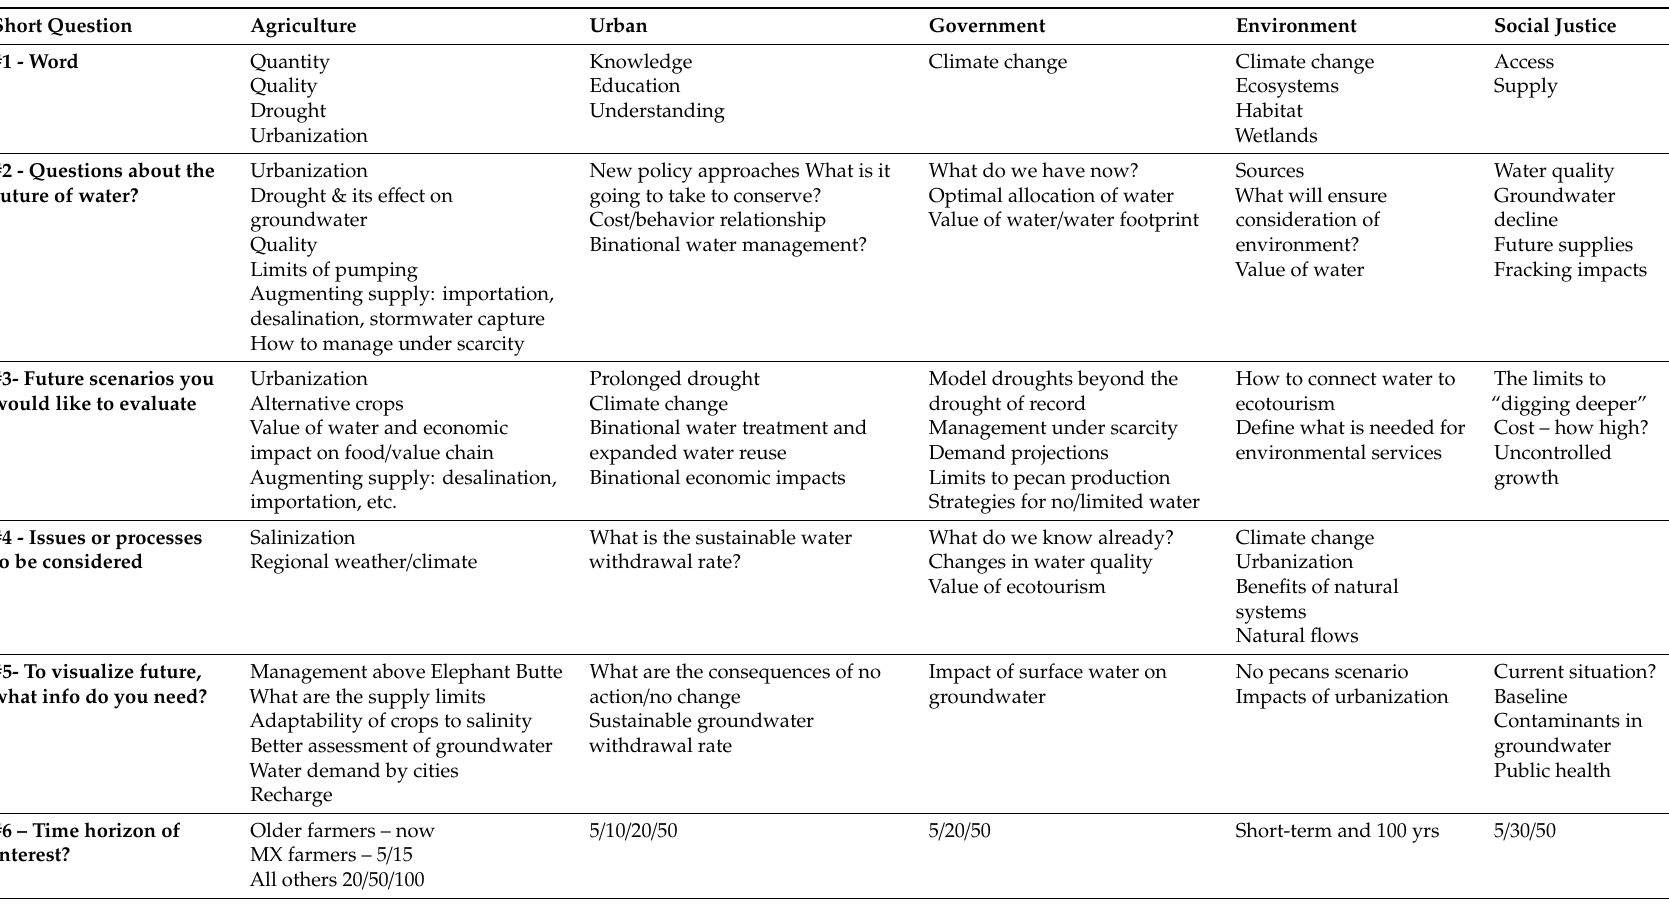
Table 2. Divergent stakeholder views by